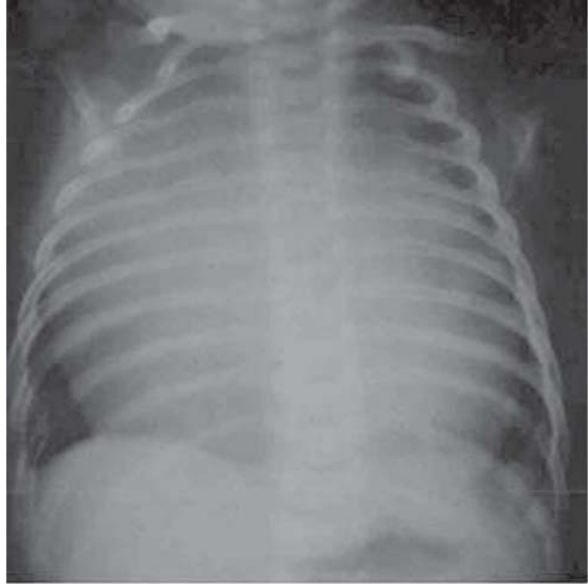
Fig. 1 – Radiografia de tórax exibindo acentuado aumento de área cardíaca